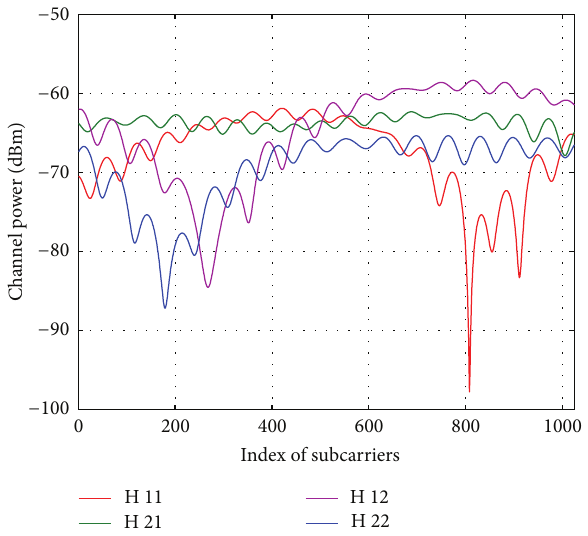
Figure 6: Instantaneous frequency power profile example for a 2 × 2 picocell